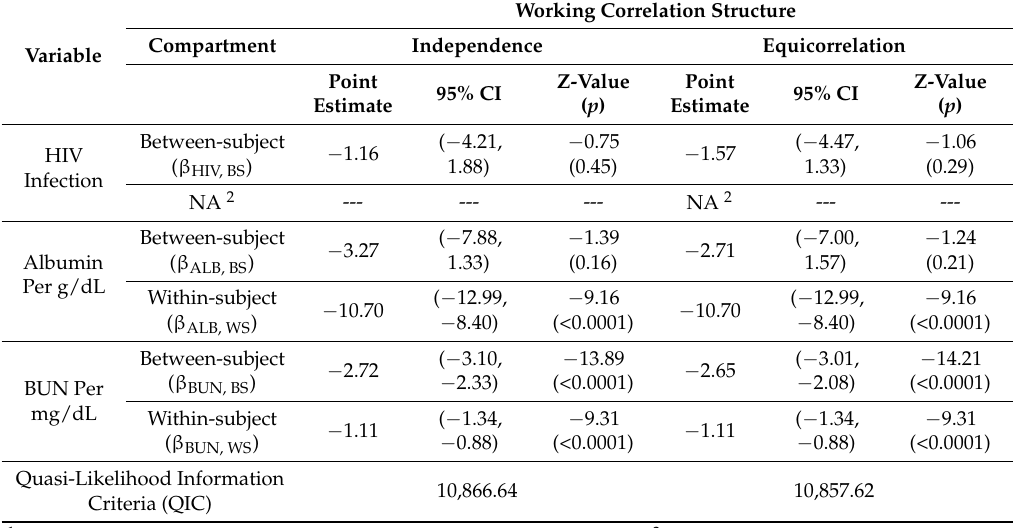
Table 2. Within- and between-subject decomposition regression parameter estimates using GEE 1 for EGFR = HIV infection, serum albumin and BUN in the Bronx WIHS. Working Correlation Structure Compartment Variable